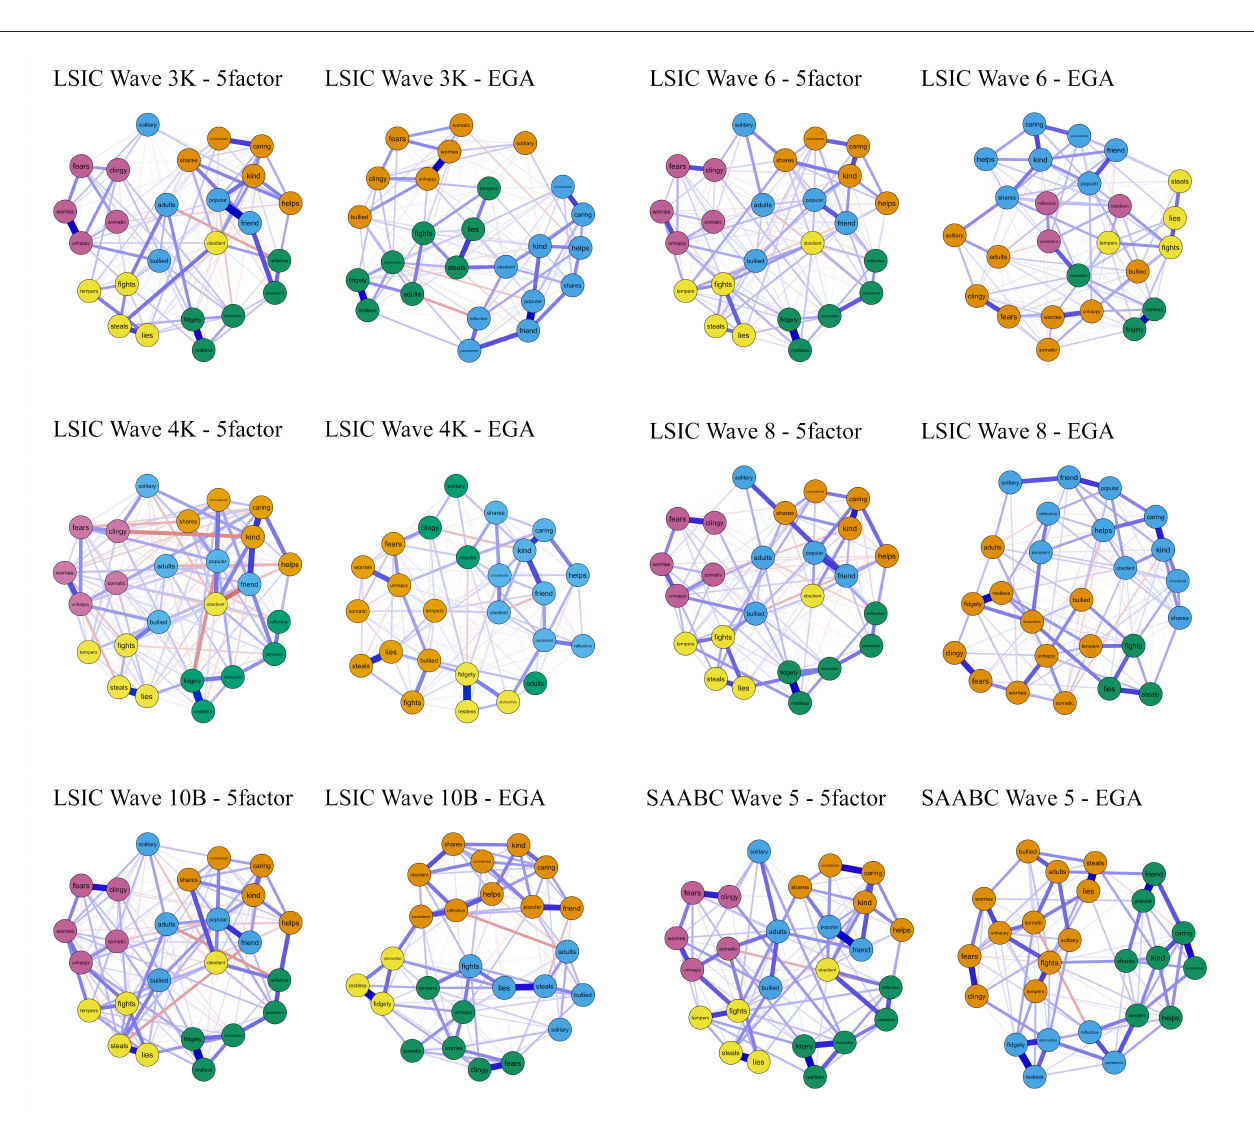
FIGURE 1 | Networks of the caregiver-informant SDQ version 4 to 10 years in Aboriginal and/or Torres Strait Islander children. Note. Nodes were colored according to the SDQ five-factor structure (left column) and EGA identified structure (right column). SDQ, Strengths and Difficulties Questionnaire.